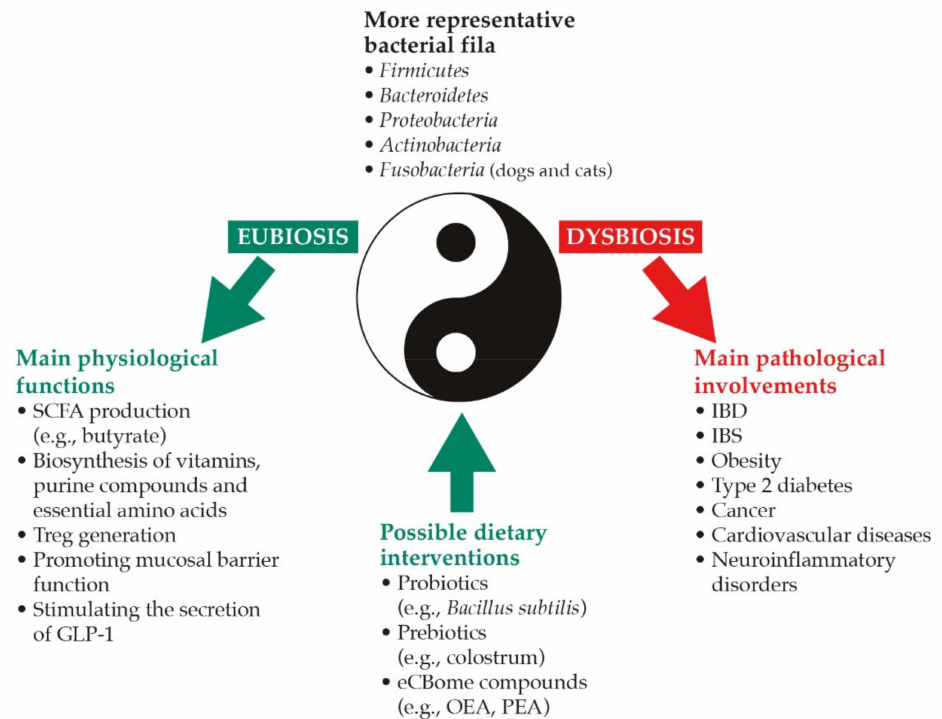
Figure 1. The yin and yang of gut microbiome in intestinal health and beyond. See text for de- tailed explanation. Abbreviations: eCBome, endocannabinoidome; GLP-1, glucagon-like peptide-1; IBD, inflammatory bowel disease; IBS, irritable bowel disease; OEA, oleoylethanolamide; PEA, palmitoylethanolamide; SCFA, short-chain fatty acid; Treg, regulatory